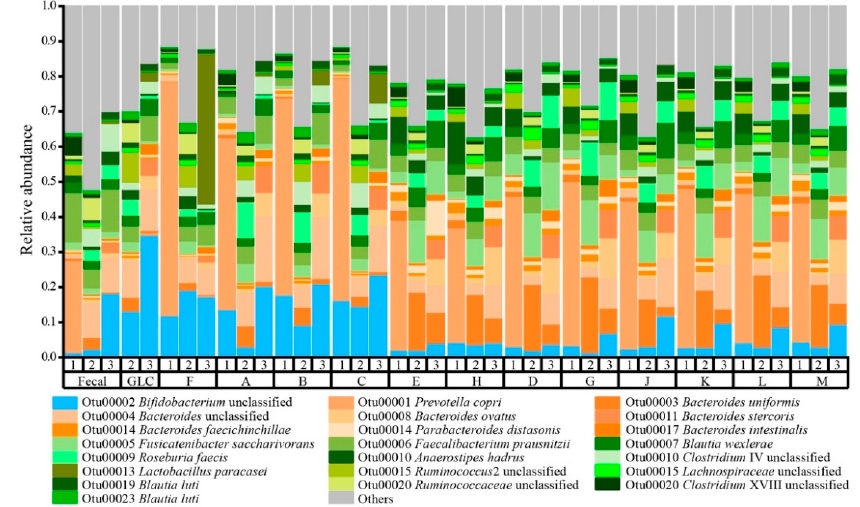
Figure 6. Relative abundances of dominant operational taxonomic units (OTUs ≥ 1%) after 48 h of fermentation of distinct glucan structures by donor microbiota and glucan. D1, D2, and D3 represent Donor 1, Donor 2, and Donor 3 inocula, respectively. Letters indicate different glucans, except for the glucose positive control (GLC) and the fructans positive control (F). Shades of green represent members of phylum Firmicutes , shades of orange represent members of phylum Bacteroidetes , and shades of blue represents members of phylum Actinobacteria . Taxa observed at a relative abundance of <1% relative abundance are combined into “Other”.